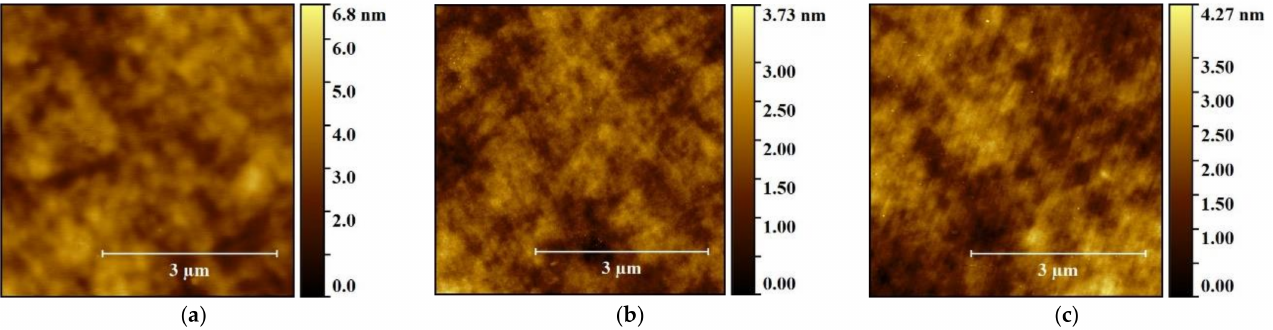
Figure 3. 5 × 5 µ m 2 2D AFM topography images of Si thin films: ( a ) S1; ( b ) S2; ( c ) S3 sample,